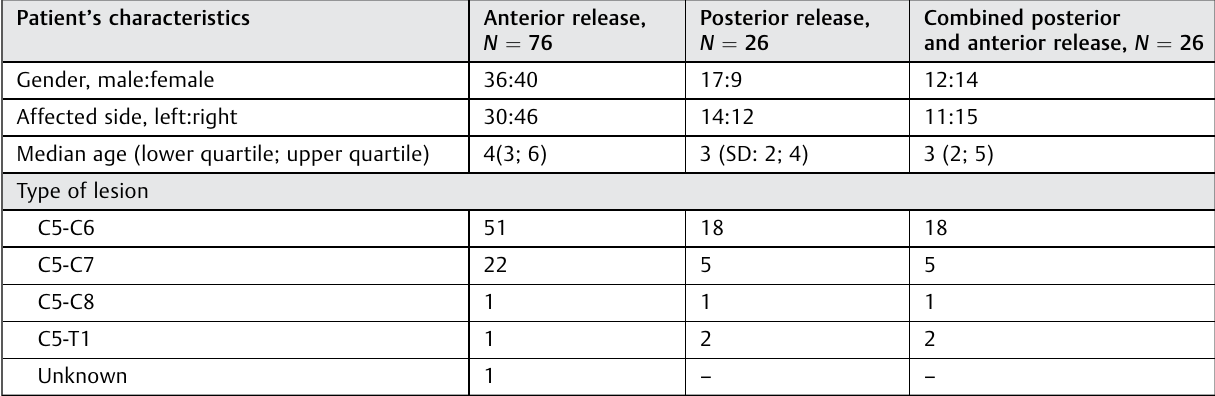
Table 1 Patient characteristics Patient ’ s